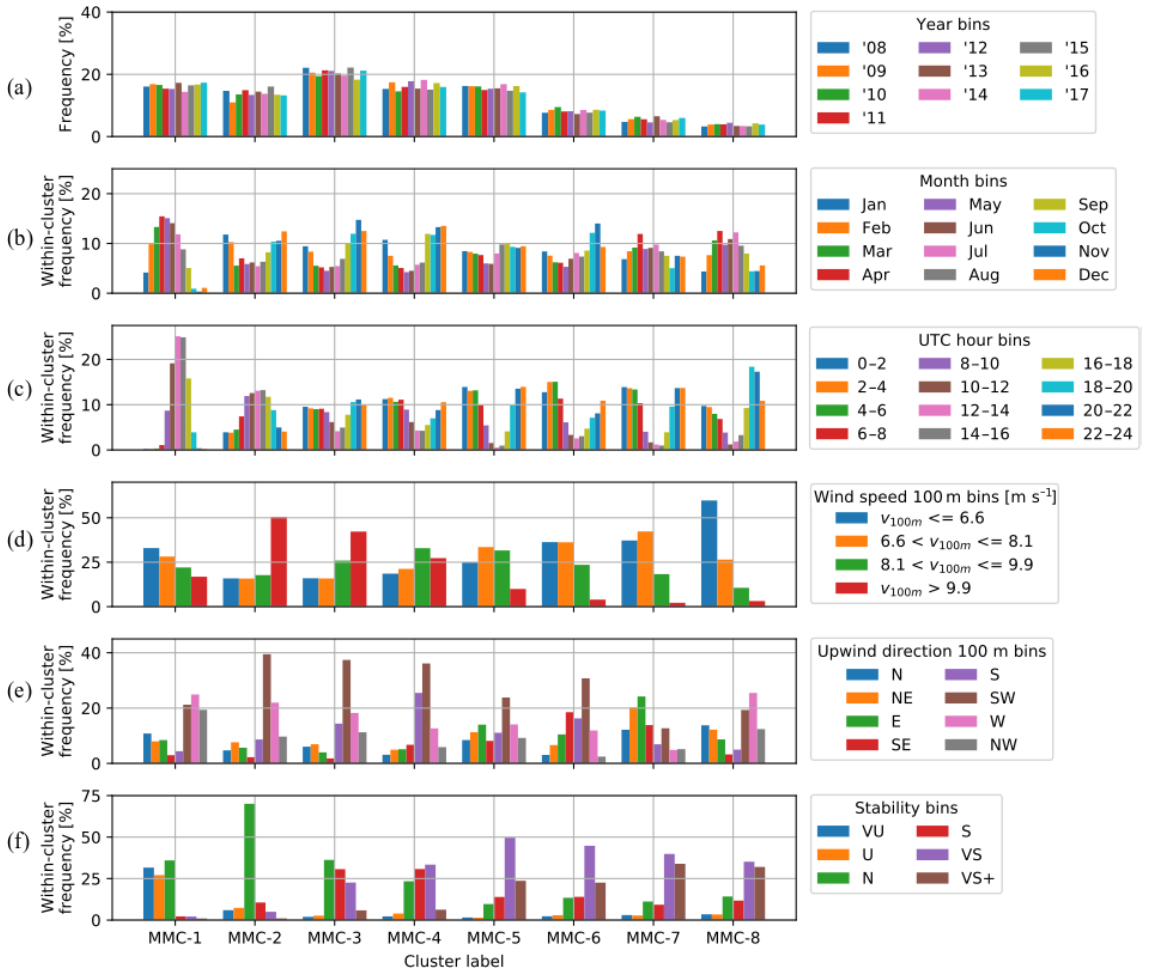
Figure 14. Frequency distributions broken down into bins by time of occurrence (a, b, c) , wind speed and direction at 100m (d, e) , and atmospheric stability (f) for the filtered onshore dataset. The wind speed bin limits are chosen such that the frequency over all clusters for each bin is roughly the same. The stability bins correspond to the classes in Table 1 together with the VS+ bin ( Ri B ≥ 0 . 2). The other distributions have equal bin